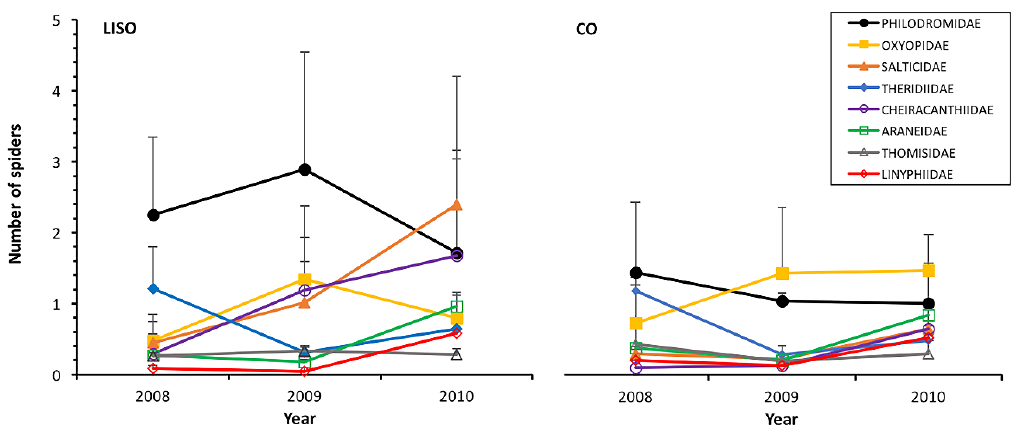
Figure 3. Annual abundance (mean ± SE, beating of 90 branches) of the different families of spiders in pear orchards over three years. LISO, low-intensity spraying orchards; CO, conventional orchards.